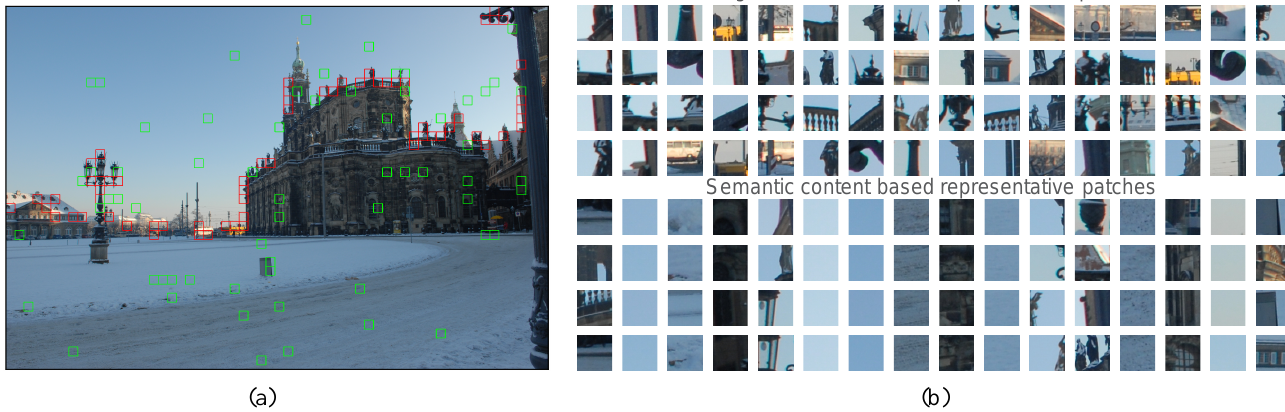
Figure 2. Illustration of multiple criteria-based patch selection. ( a ) Selected edge and textual patches (in red square) and semantic representatives (in green square); ( b ) visualization of selected